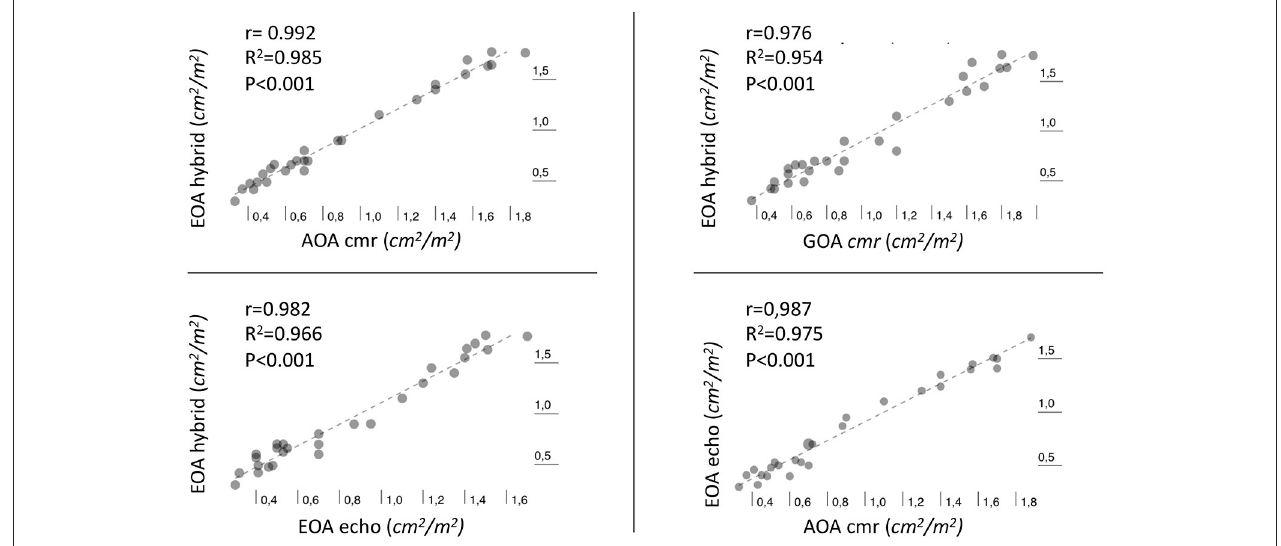
FIGURE 3 | Scatter plot with best-fitting regression line illustrating the Pearson correlation ( r ) and the coefficient of determination R 2 between different methods of estimation of aortic valve area.